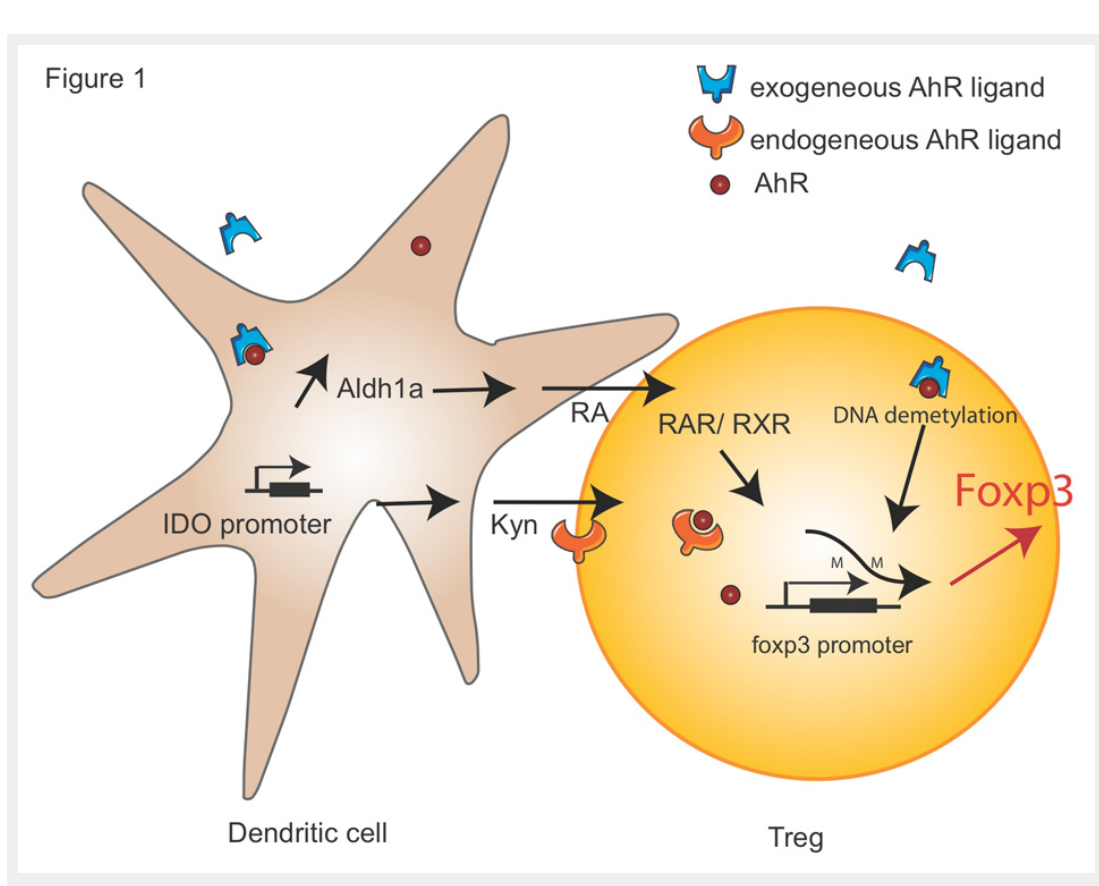
AhR signalling in Tregs. The molecular mechanisms by which AhR promotes Foxp3 + Tregs cell are shown. Exogenous AhR ligand induces tolerogenic DCs by multiple pathways. Firstly, the activation of AhR enhances the expression of Aldh1a1 which drives RA secretion. In T cells, RA binds to RAR and RXRs, which in turn bind to the Foxp3 promoter. Secondly, the activation of AhR induces the formation of Kyn in an IDO-dependant manner in DCs. Kyn further acts as an endogenously AhR ligand and promotes Foxp3 expression. In addition, the activation of AhR mediates partial demethylation of Foxp3 promoter in CD4 + T cells. RA, retinoic acid; RAR, retinoic acid receptor; RXR, Retinoid X Receptor; Kyn, Kynurenine; IDO, Indoleamine